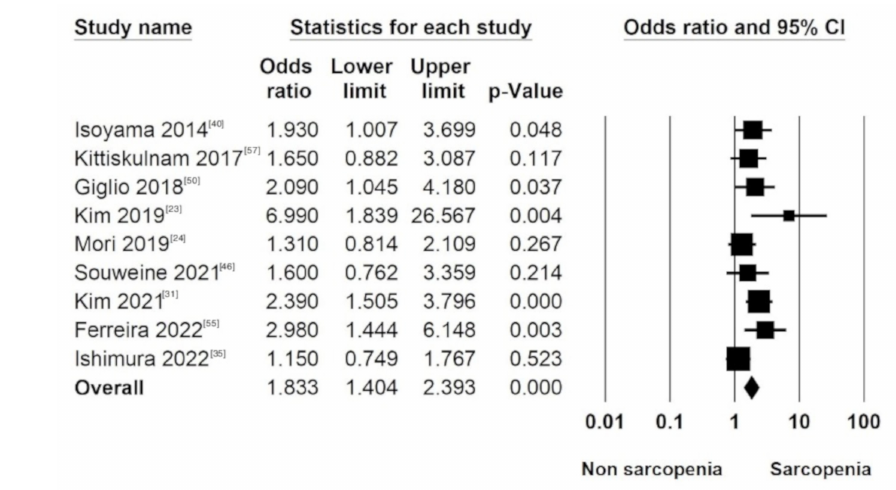
Figure 3. Forest plot displaying the pooled adjusted odds ratio for all-cause mortality